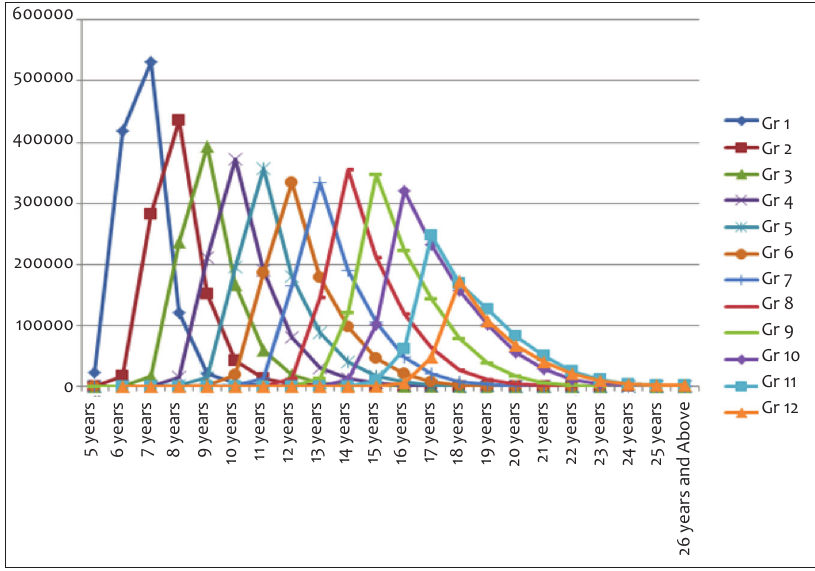
Figure 3: Enrolment by grade and age in 2011 (Source: ASS data for 2011) Performance